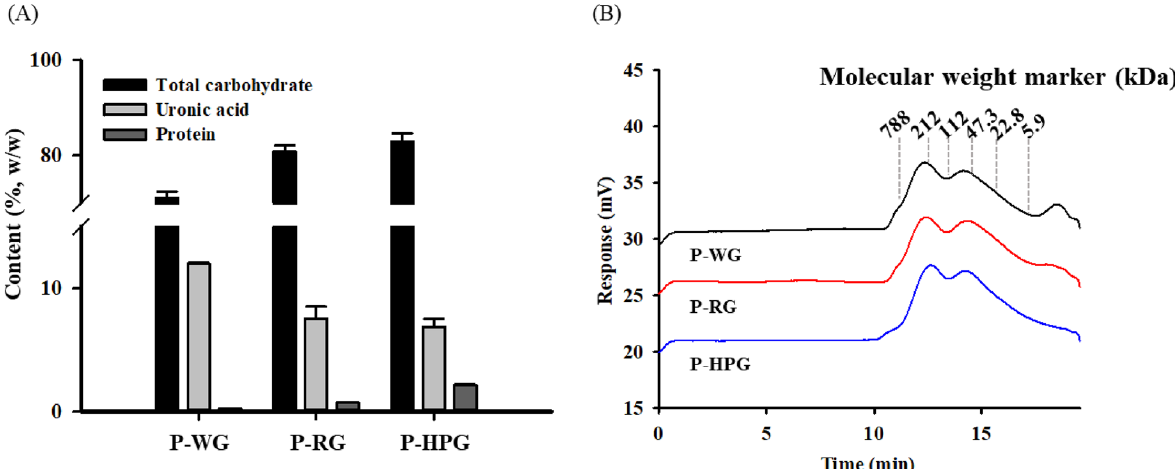
Fig. 3 Preparation and chemical properties of P‑WG, P‑RG, and P‑HPG. a Chemical properties of P‑WG, P‑RG, and P‑HPG. Bars and error bars represent the mean and standard deviation, respectively. Break range on the y‑axis is 15–70%. b HP‑GFC chromatograms of P‑WG, P‑RG, and P‑HPG. The elution times of pullulan molecular weight markers are indicated by dotted lines. The two major peaks of peak‑1 and peak‑2 are indicated. HP-GFC high‑performance gel filtration